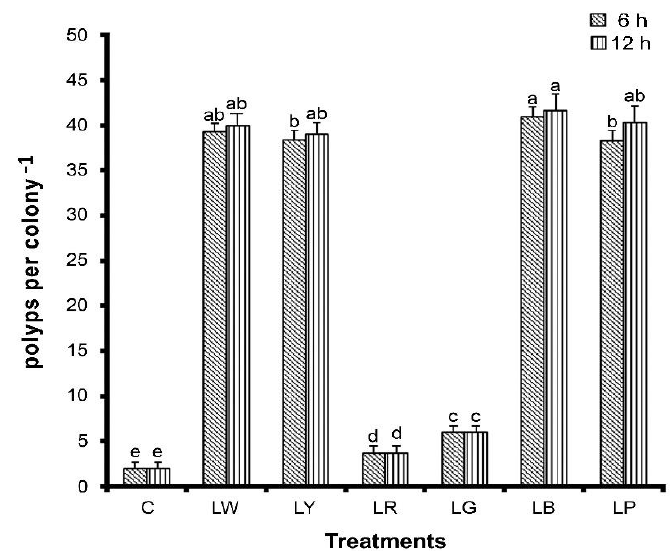
Figure 1. Number of G. columna polyps after illumination under different light sources. Goniopora columna specimens were treated with LW (444 – 696 nm), LG (500 – 540 nm), LY (570 – 590 nm), LB (440 – 470 nm), LR (620 – 650 nm), or LP (400 – 430 nm) for 6 or 12 h per day. C was in the dark. After 8 weeks, polyps were counted. Bars represent ± SD ( n = 30). Letters represent significant differences among groups ( p < 0.05).